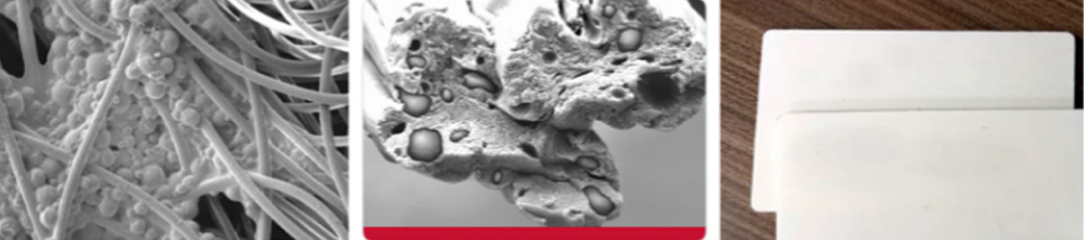
Figure 17. Form-stable PCMs: microencapsulated PCM bound to the surface of textile fibres ( left ); integrated into textile fibres ( middle ); plate-shaped composite material with embedded PCM ( right ), Mehling et al. [148]. Reproduced with permission from Elsevier.